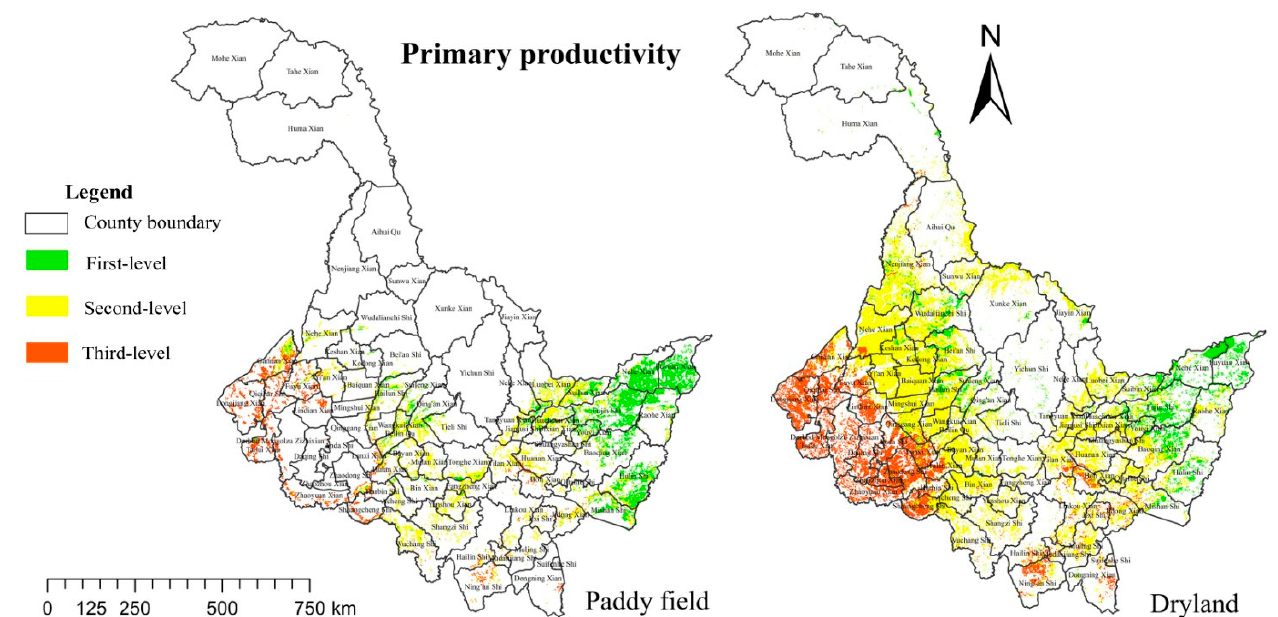
Figure 5. The grade of soil primary productivity function of paddy fields and drylands.